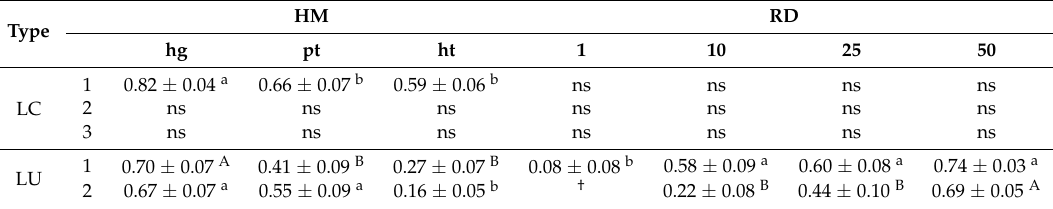
Table 10. Differences between homogeneity (HM) levels, comparing homogeneous (hg), potentially homogeneous (pt) and heterogeneous (ht) points and the radius (RD) in relation to land cover (LC) and land use (LU) agreement (0–1) between FotoQuest Austria and LUCAS 2015. Adjusted means ± standard errors are shown. Different letters indicate significant differences in a given level and predictor at a significance level of α =